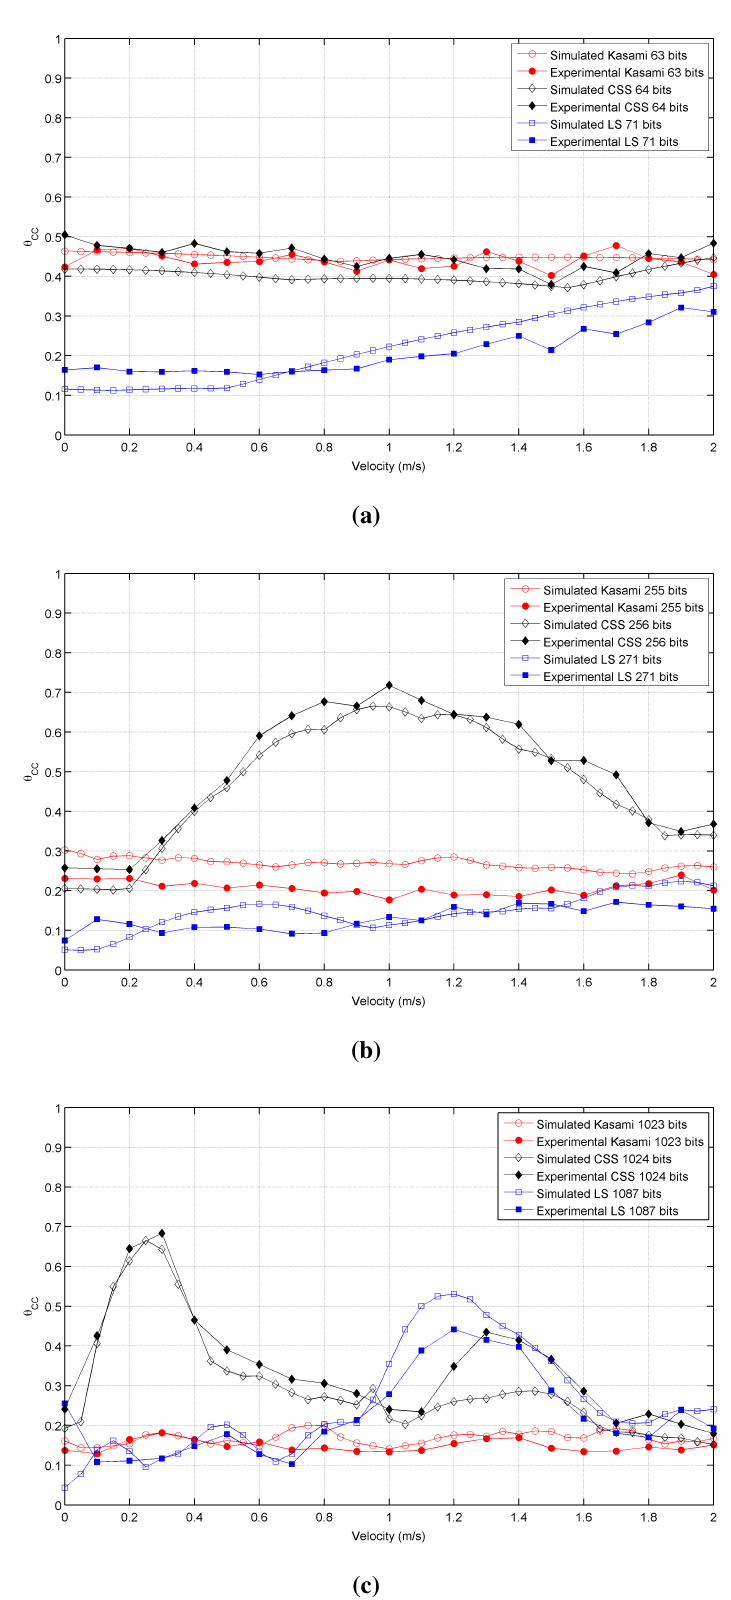
Figure 10. Simulated and experimental cross-correlation bounds for the sequences with lengths close to (a) 64 bits (b) 256 bits (c) 1,024